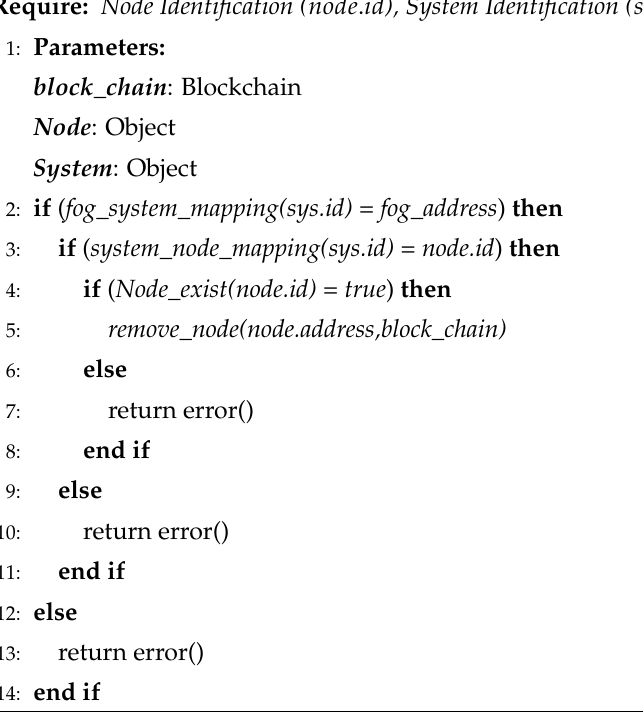
Algorithm 5 Node removal rules for smart